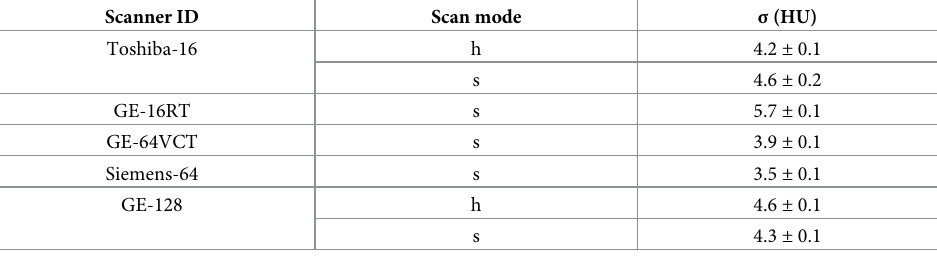
Table 4. Noise ( σ ) values (mean ± standard deviation across five repeated measurements), for each CT scanner/ acquisition protocol. Scanner